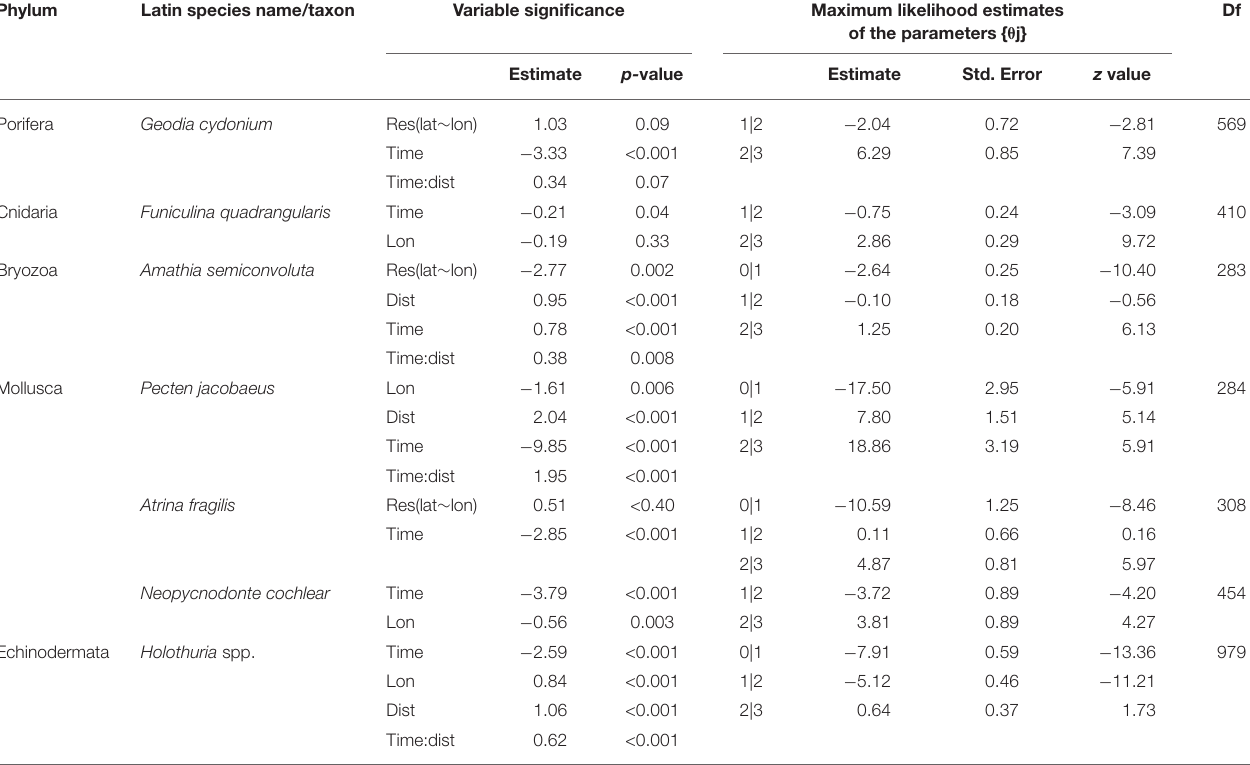
TABLE 3 | Summary of the parameters of the best ordinal regression models (clmm2 models).